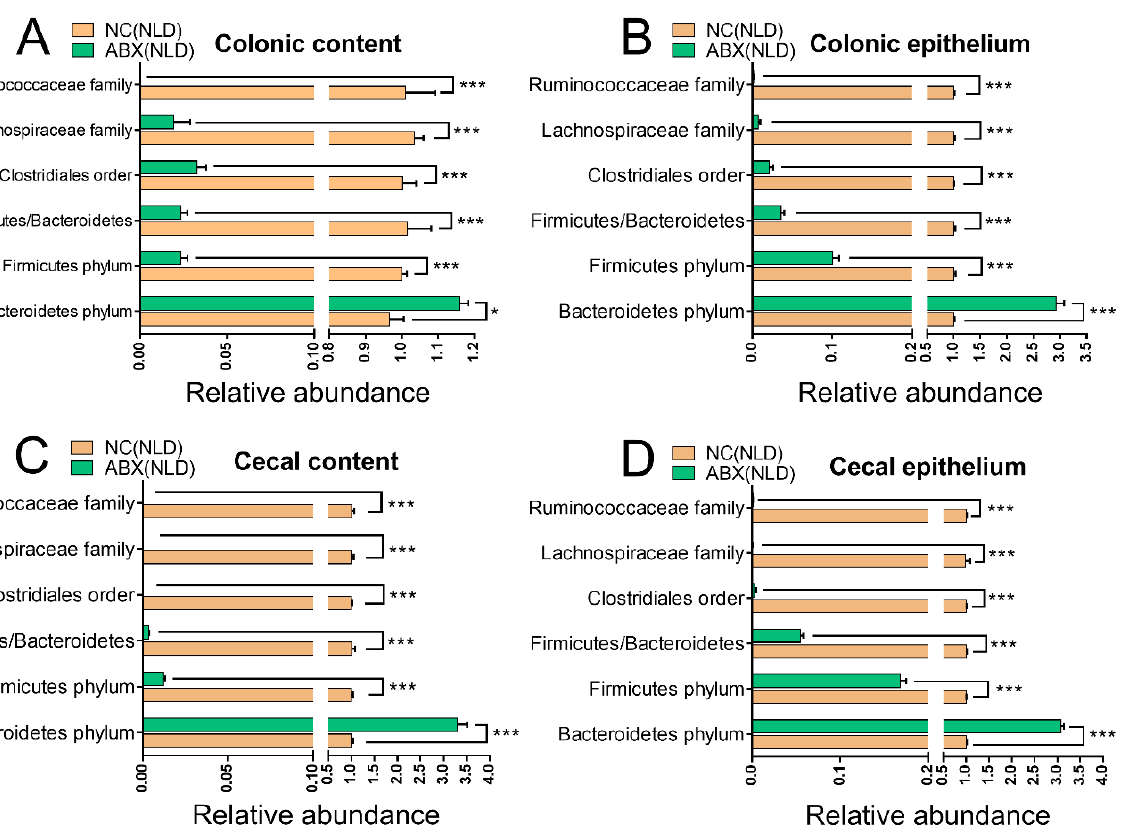
Figure 1. The relative abundance of gut microbiota in colonic and cecal contents and epithelium of NC and ABX mice under NLD. NC (NLD), the negative control mice managed under normal light–dark cycle; ABX (NLD), the antibiotic-treated mice managed under normal light–dark cycle. Representative charts of the relative abundance of Bacteroidetes phylum, Firmicutes phylum, Clostridiales order, Lachnospiraceae family, Ruminococcaceae family, and the ratio of Firmicute to Bacteriodetes in colonic content ( A ), colonic epithelium ( B ), cecal content ( C ), and cecal epithelium ( D ) were detected using RT-PCR, where the 16S rRNA gene amplified by the total bacterial primer set was used as an internal reference, and the abundance of gut microbiota in ABX (NLD) was relative to NC (NLD). Values were means, with standard error of the mean. * p < 0.05, *** p <